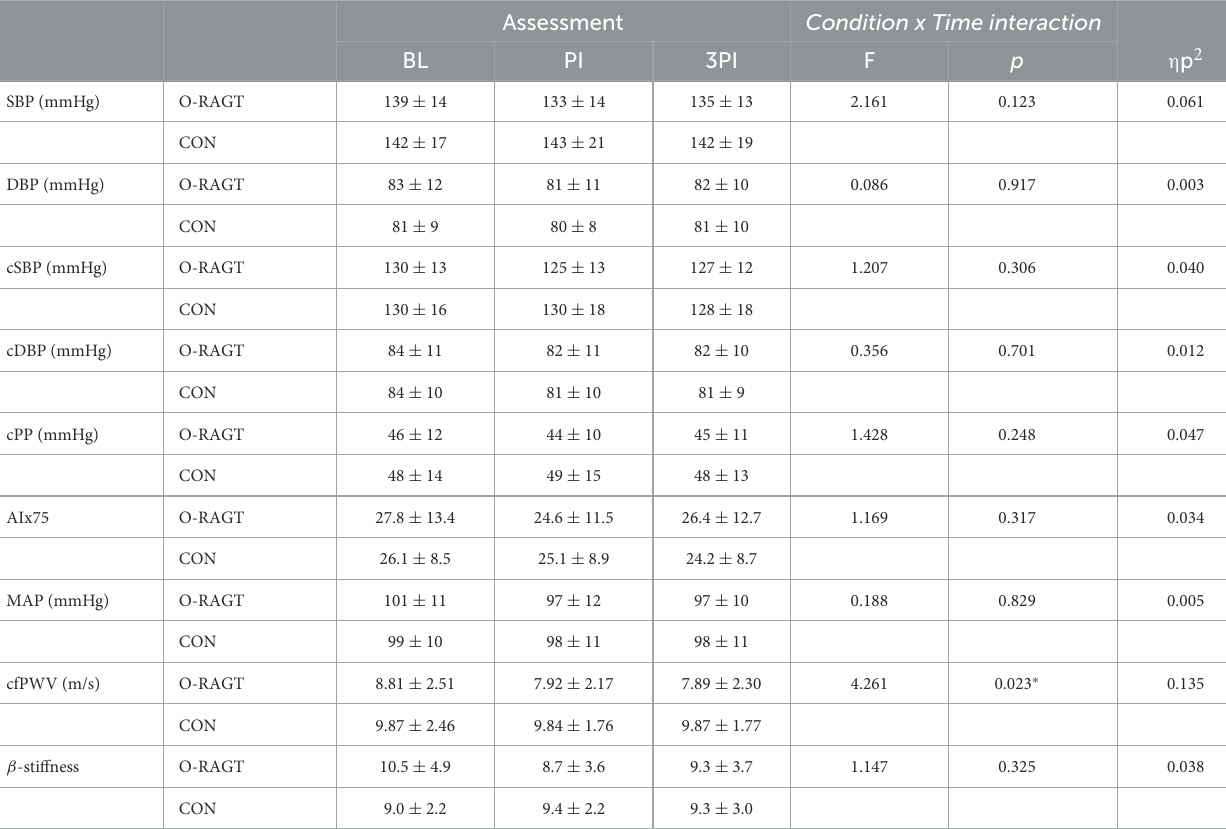
TABLE 2 PWA, cfPWV and local arterial stiffness outcome measures reported at baseline (BL) and post-intervention (PI, 3PI) for O-RAGT and control (CON)